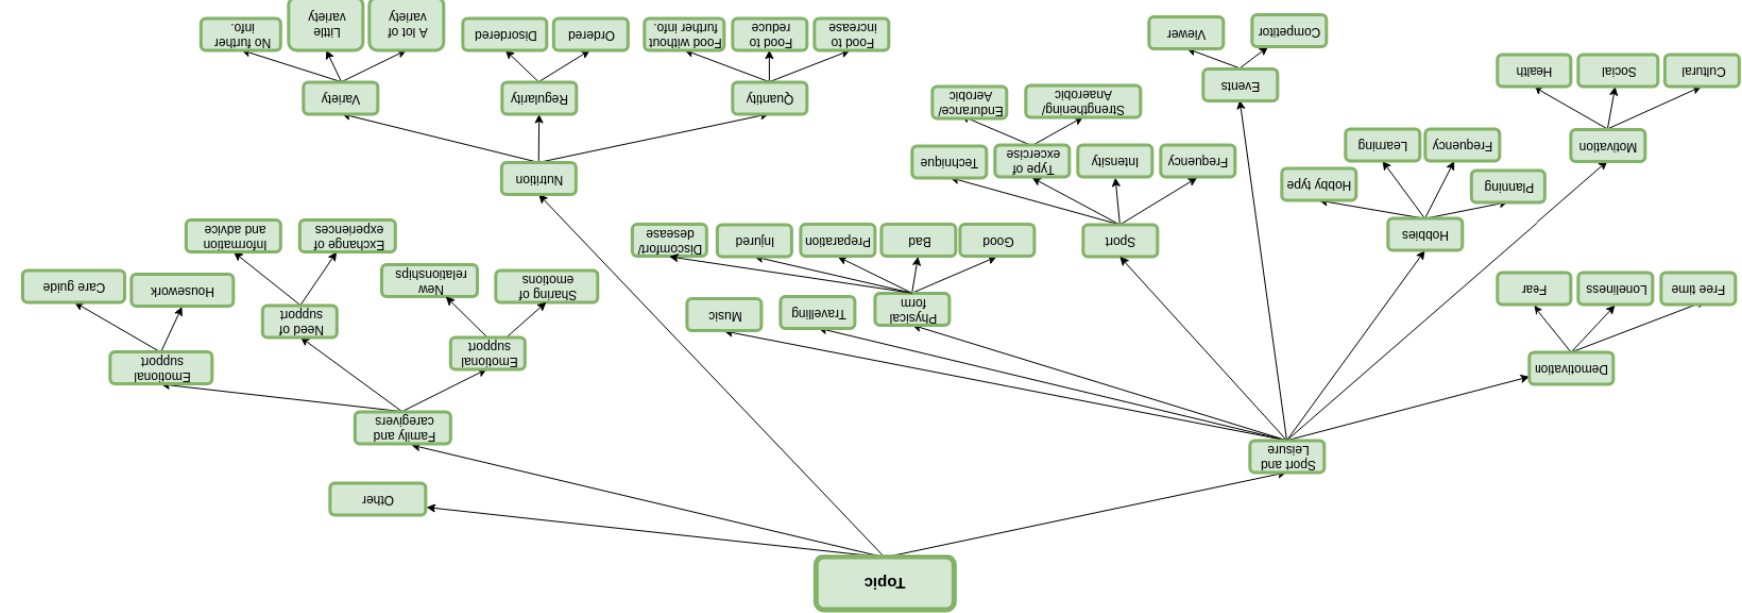
Figure A1. Topic label